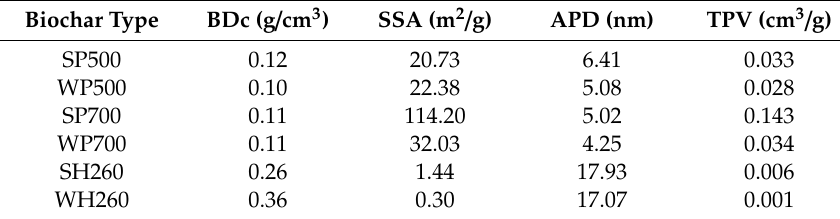
Table 1. Basic properties of pyrochar and